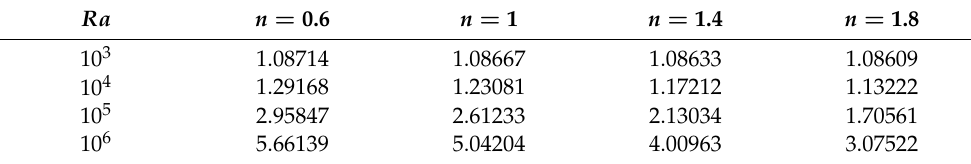
Table 4. The values of the average Nusselt number ( Nu avg ) at the heated boundary.